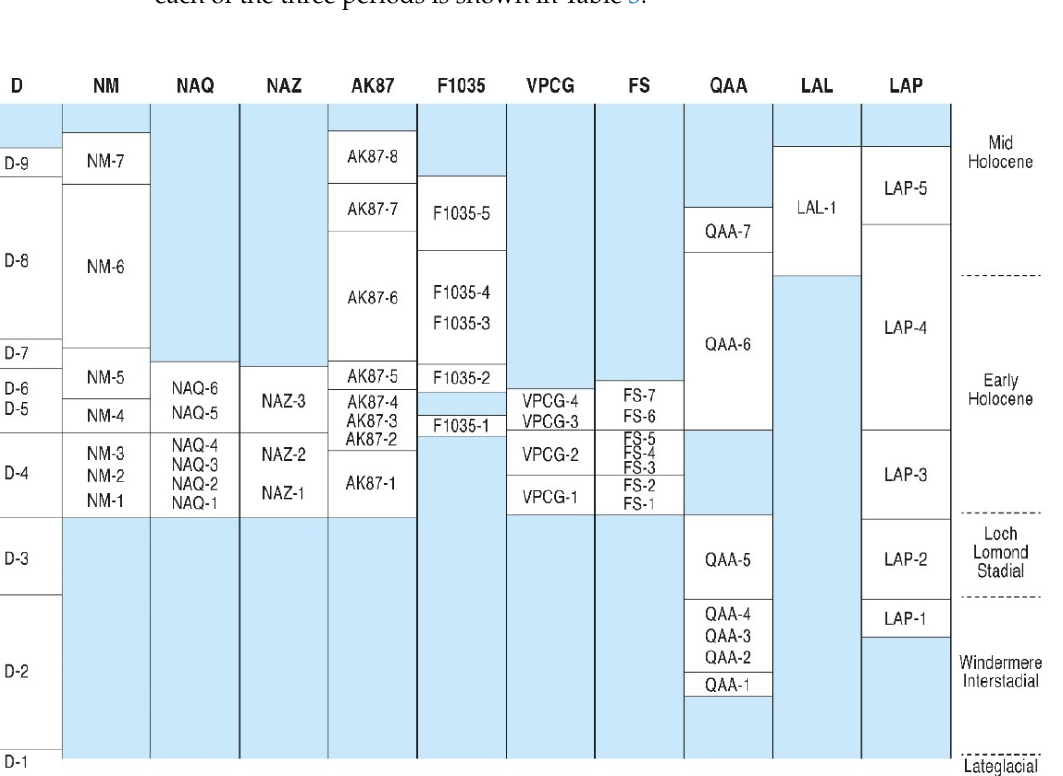
Table 3. Synopsis of major vegetation changes and palaeoenvironmental history. Most of the ages for the immigration of the major trees are strongly asynchronous. Quoted ages are in radiocarbon years. c. 7200–5000 14 C BP (Atlantic) Alnus - Ulmus - Quercus - Corylus Alnus is added to the tree flora. Its immigration is asynchronous varying from c. 7600 14 C BP [28] to c. 6000 14 C BP. Tilia appears late in the period. Vegetation disturbance is significant by the end of the mid-Holocene with heliophytic taxa forming a significant contribution to the local (and regional?) pollen rain. Late Mesolithic people were present and human occupation was probably an important factor affecting the development of the vegetation and in some places disturbance might be linked to the local rise of alder. The Ulmus Decline seems not to be recorded. Almost all of the former lake is covered in reed and/or sedge swamp and alder carr and only very small pockets of open water are left in the deepest areas. Microcharcoal is either absent or in very low frequencies and burning was not a significant influence in the damper, denser mid-Holocene forest. c. 10,000–c.7200 14 C BP (Pre-Boreal and Boreal) Betula (c. 10,000–c.9000) Corylus (c. 9000–c.8000) Corylus - Pinus - Ulmus - Quercus (c. 8000–c. 7200) Encroachment of lake edge vegetation and reed swamp was rapid and occurred from the earliest point of the Holocene. The importance of Salix and Populus carr is variable around the lake edge although its detection depends to a large extent on pollen preservation and sample location, relative to the water’s edge. After succession through Juniperus and Salix shrubs, Betula dominated the first Holocene millennium. Rapid replacement of Betula by Corylus occurred around 9000 14 C BP, with hazel thickets established both locally and regionally. Pinus and Ulmus enter the woodland in places in the centuries leading up to 8000 14 C BP. Immigration of Quercus is highly asynchronous,